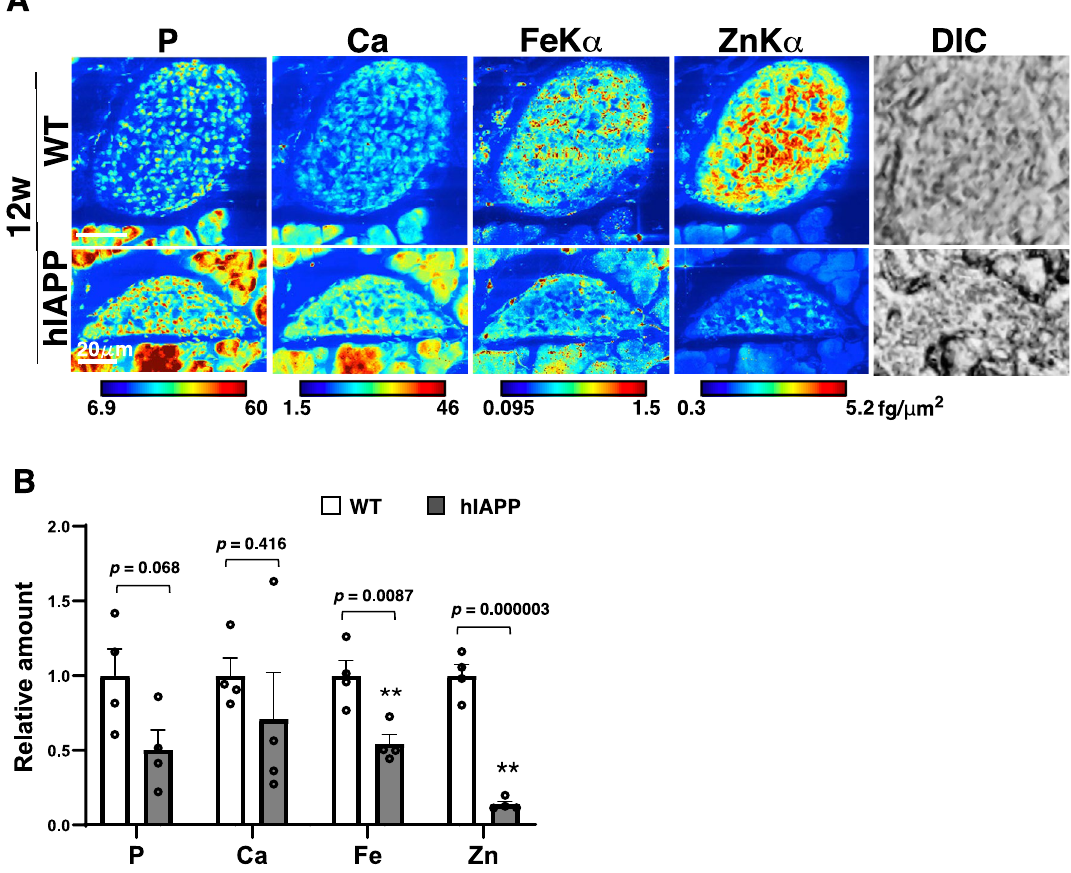
Figure 5. Decreased iron in the islets of 12-week-old hIAPP-Tg mice. ( A ) Mapping images of pancreatic islets from 12-week-old mice. Color bar, femtograms per square micrometer; DIC: differential interference contrast image; Scale bar, 20 µm. ( B ) Relative amounts of each element in isolated islets were measured using ICP-MS (n = 4 for genotype). WT: WT mice, hIAPP: hIAPP-Tg mice, Data are given as means ± SEM. ** p < 0.01 (WT vs.